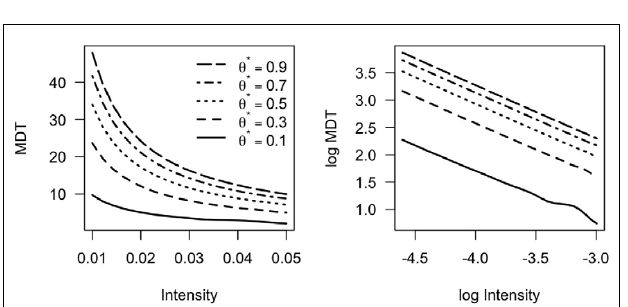
values. Left: Mean decision time (MDT) vs angular distance. Middle: log MDT vs log Angle. Right: Proportion correct vs Angle. θ ∗ : response criterion value.